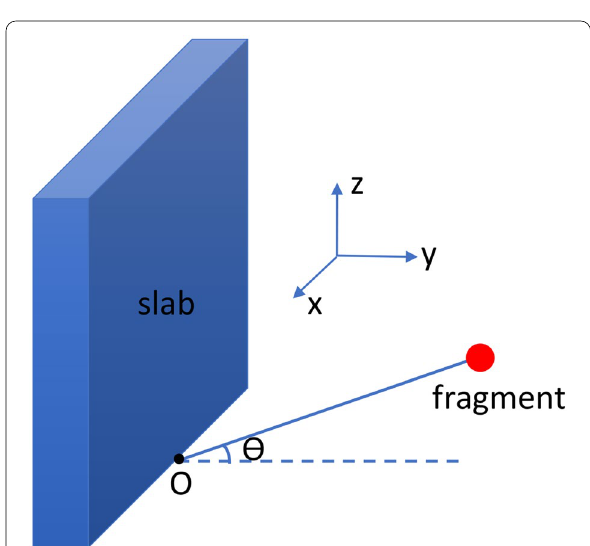
Fig. 17 The definition of horizontal